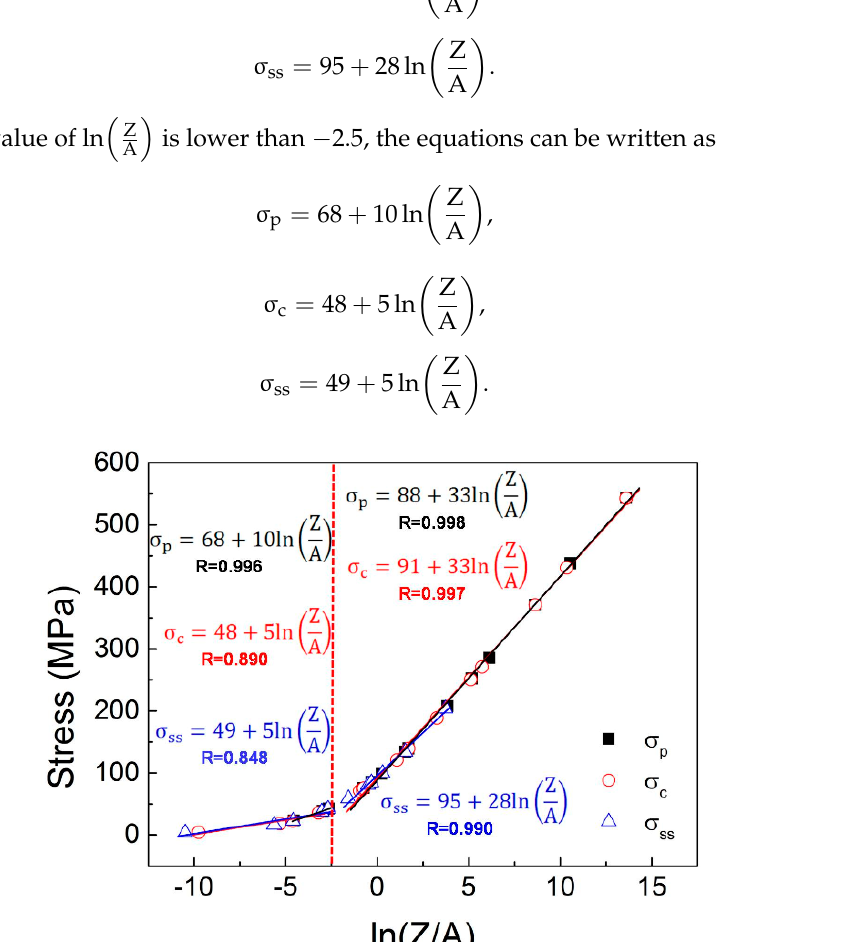
(cid:16) (cid:17) Z ) for the Fe-6.5wt. %Si alloy. for the Fe-6.5wt. %Si alloy. A (cid:2885)